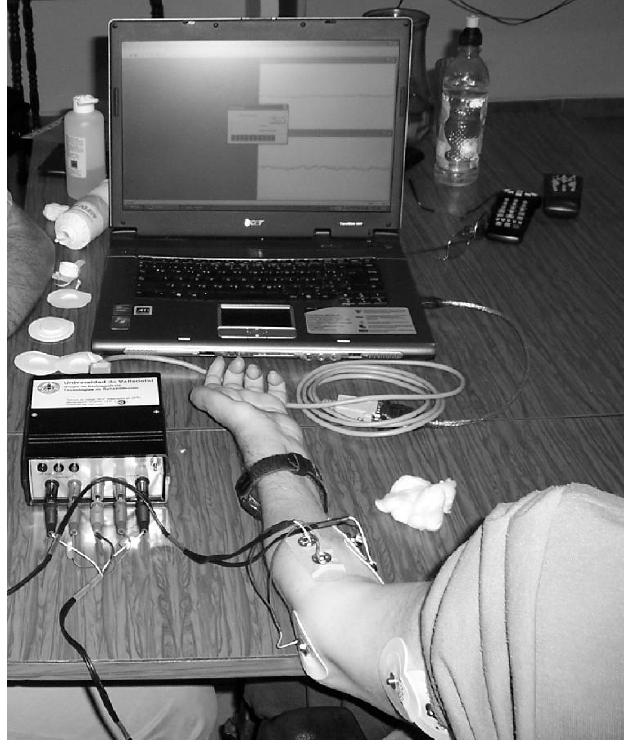
Figure 22. Test at home: patient with tetraplegia during the calibration